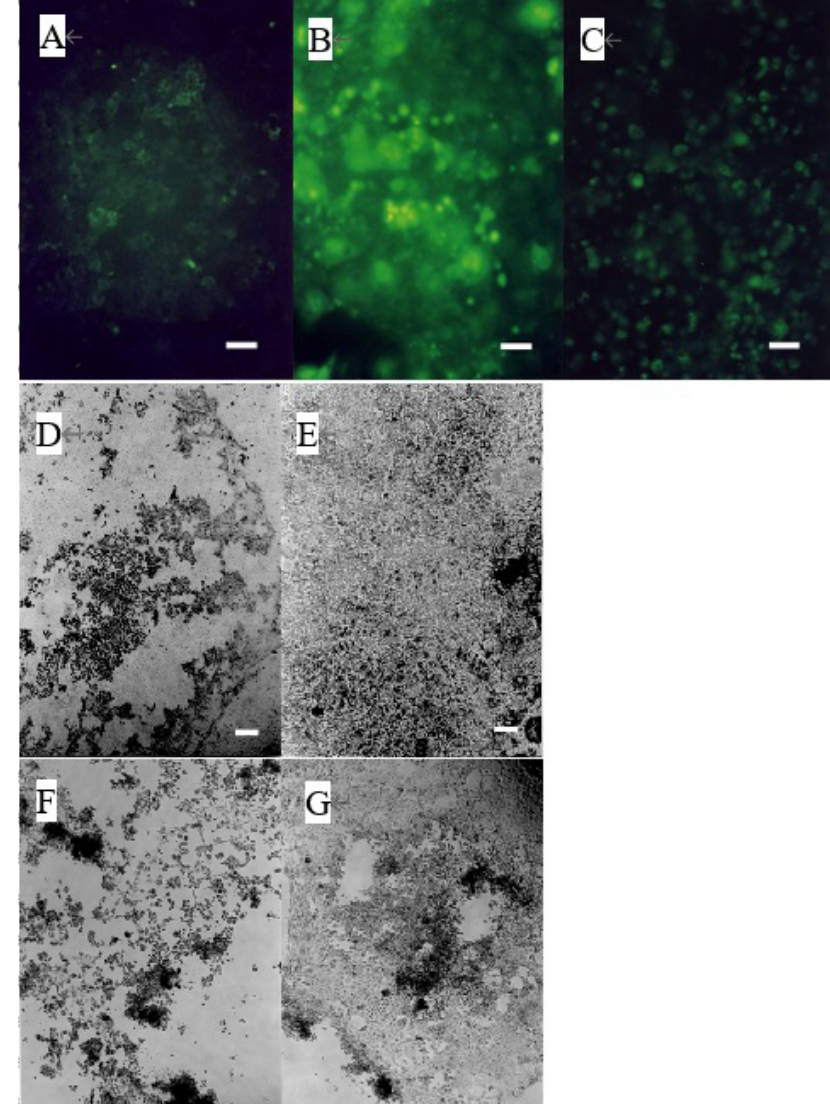
Figure 5. Protease inhibitor-induced suppression of cell exfoliation at a low concentration of 12-KETE. (A) DNA fragmentation (24 h after addition of 10 μM 12-KETE) in the presence of feeder cells (n = 3), (B) YOPRO-1 staining (3 h after addition of 10 μM 12-KETE) in the presence of feeder cells (n = 3), (C) MMP activation (18 h after addition of 10 μM 12-KETE) in the presence of feeder cells (n = 3), (white bars in A, B, C: 25 μm). Results in the absence of feeder cells were the same as those in their presence (data not shown). (D) At 23.5 h after addition of 10 μM 12-KETE in the presence of feeder cells, (E) At 23.5 h after addition of 10 μM 12-KETE plus 0.05 mg/mL Pefabloc in the presence of feeder cells. Replications (n = 3) of experiments showed the same results. (F) At 8 h after addition of 10 μM 12-KETE in the absence of feeder cells, (G) At 8 h after addition of 10 μM 12-KETE plus 0.2 mg/mL Pefabloc in the absence of feeder cells, (white bars in D-G: 200 μm). Replications (n = 4) of experiments showed the same results. 12-KETE, 12-oxo-5Z,8Z,10E,14Z-eicosatetraenoic acid; MMP, matrix